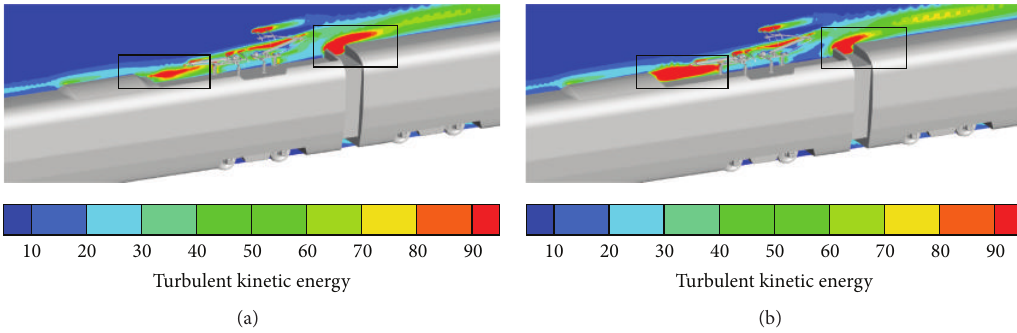
Figure 20: TKE distributions in the pantograph fairing regions: (a) Dlz2 and (b) Dlz3.